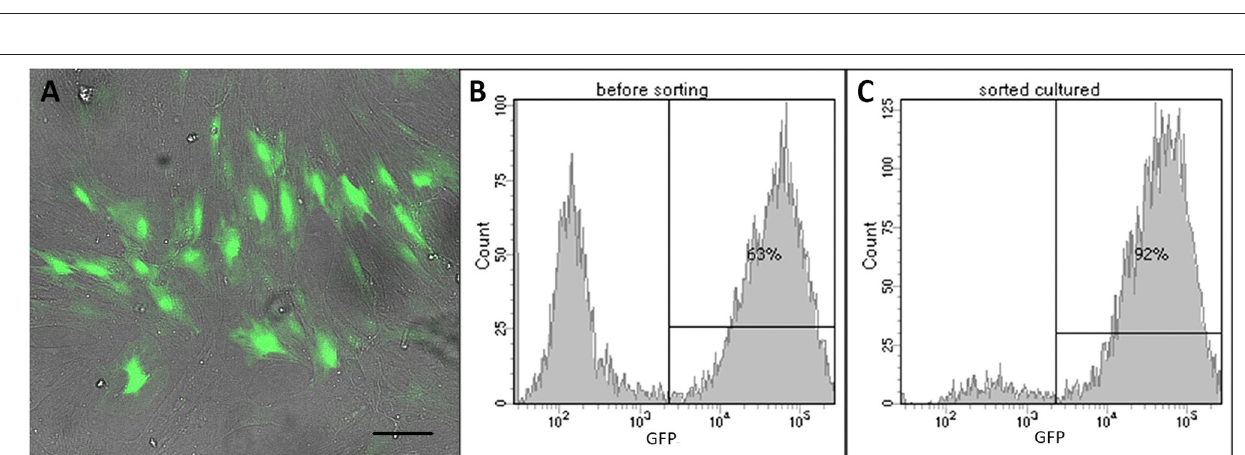
FIGURE 2 | LV-eGFP transduced rat ADSCs. (A) e-GFP expression 48h after transduction. Scale bar, 100 µ m. (B) Flow cytometry analysis of e-GFP 48h after transduction. (C) Flow cytometry analysis of e-GFP-sorted cells used for transplantation.